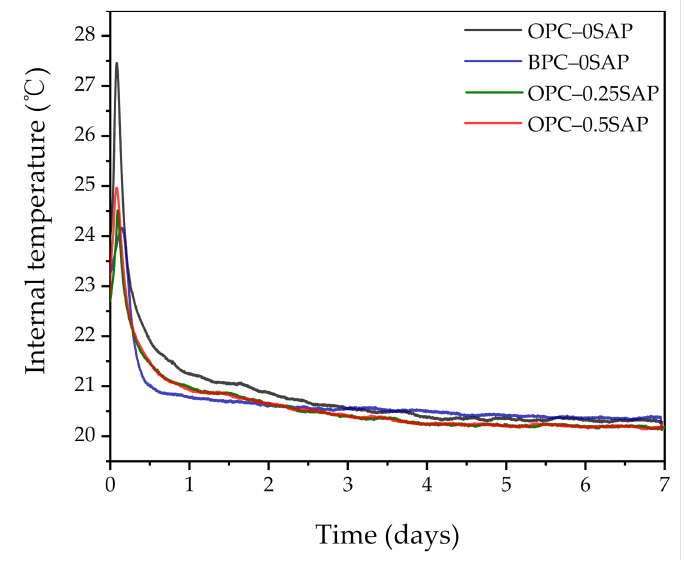
Figure 7. Variation in internal temperature with the age of curing.